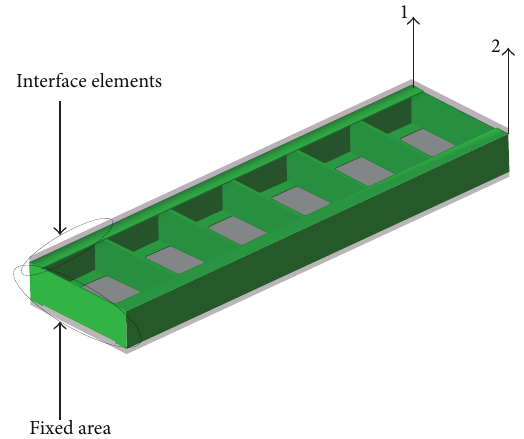
Figure 3: Finite element model of wing-box with bond strength